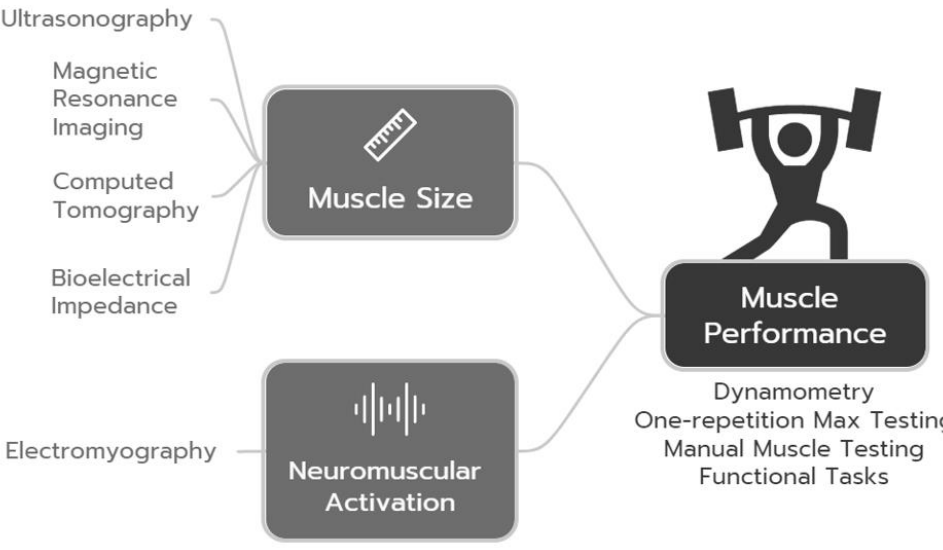
Figure 2. Assessment techniques to measure muscle